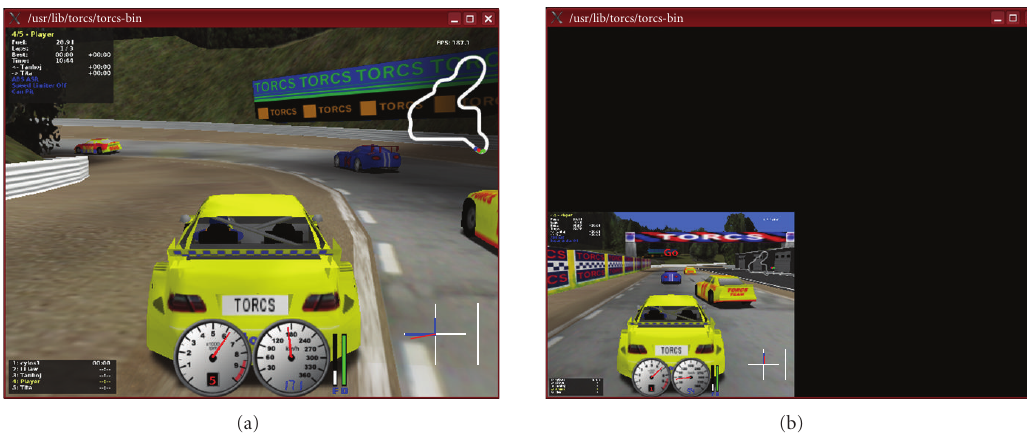
Figure 4: Rendering in resolution adapted to particular end